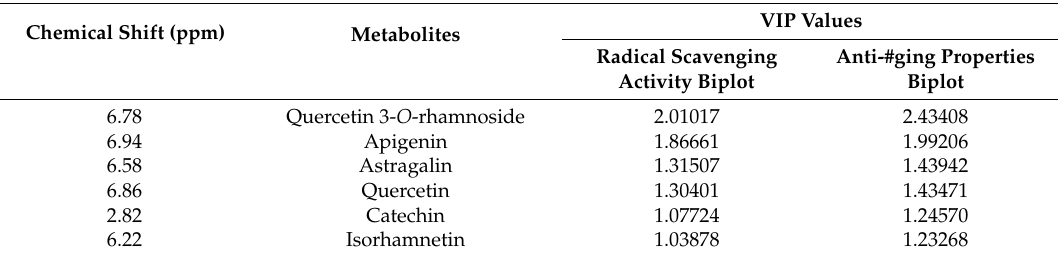
Table 2. The variable importance in the projection (VIP) values of the significant metabolites contributing to the separation and bioactivities in the biplots (PLS